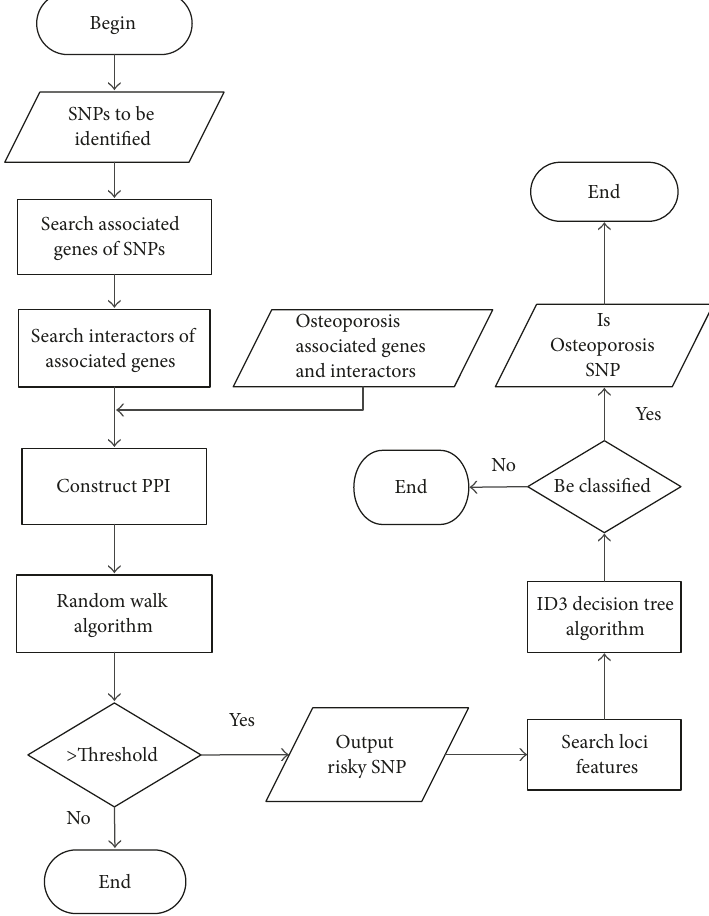
Figure 1: Process to identify the suspected risky SNPs associated with